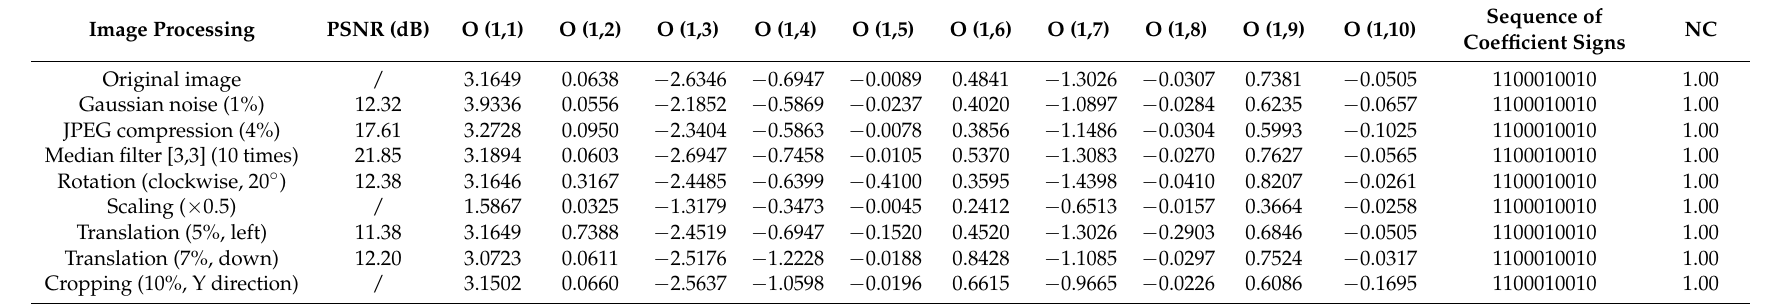
Table 1. Changes of DTCWT-DCT coefficients under different attacks for the original